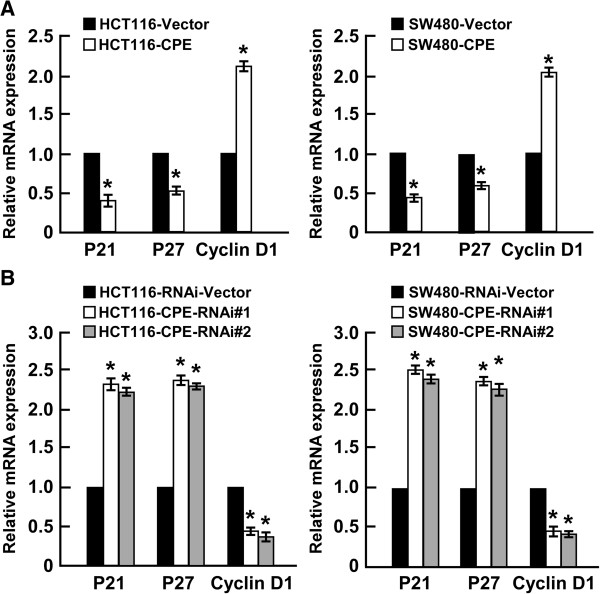
CPE regulates p21, p27, and cyclin D1 expression. (A) Overexpression of CPE downregulated p21 and p27, and upregulated cyclin D1. Real-time qRT-PCR analysis of the relative expression of p21, p27, and cyclin D1 in the indicated cells. (B) Knockdown of CPE upregulated p21 and p27, and downregulated cyclin D1. Real-time qRT-PCR analysis of the relative expression of p21, p27, and cyclin D1 in the indicated cells. Data were normalized to GAPDH control and presented as mean ± SD from three independent experiments. *: P < 0.05.